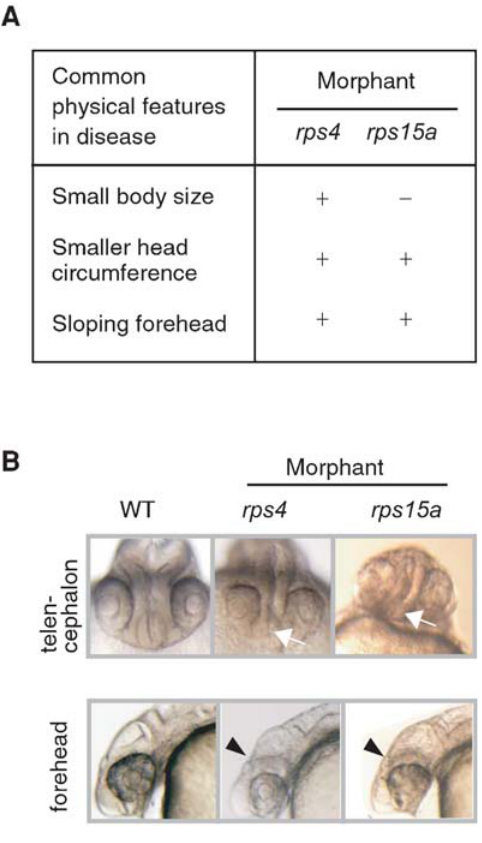
Figure 4. Similarities between the Clinical Features of Human Brain Diseases and Defects in Zebrafish Morphants (A) Common features shared between Abidi X-linked mental retardation and microhydranencephaly are listed on the left and the corresponding changes in rps4 and rps15a morphants are indicated on the right. (B) Telencephalon hypoplasia is seen in rps4 morphants, and reduction in size and deformity of the telencephalon is apparent in rps15a morphants (white arrows). Unclear subdivisions of the brain and flattened foreheads (arrowheads) can be seen in lateral views of these morphants.